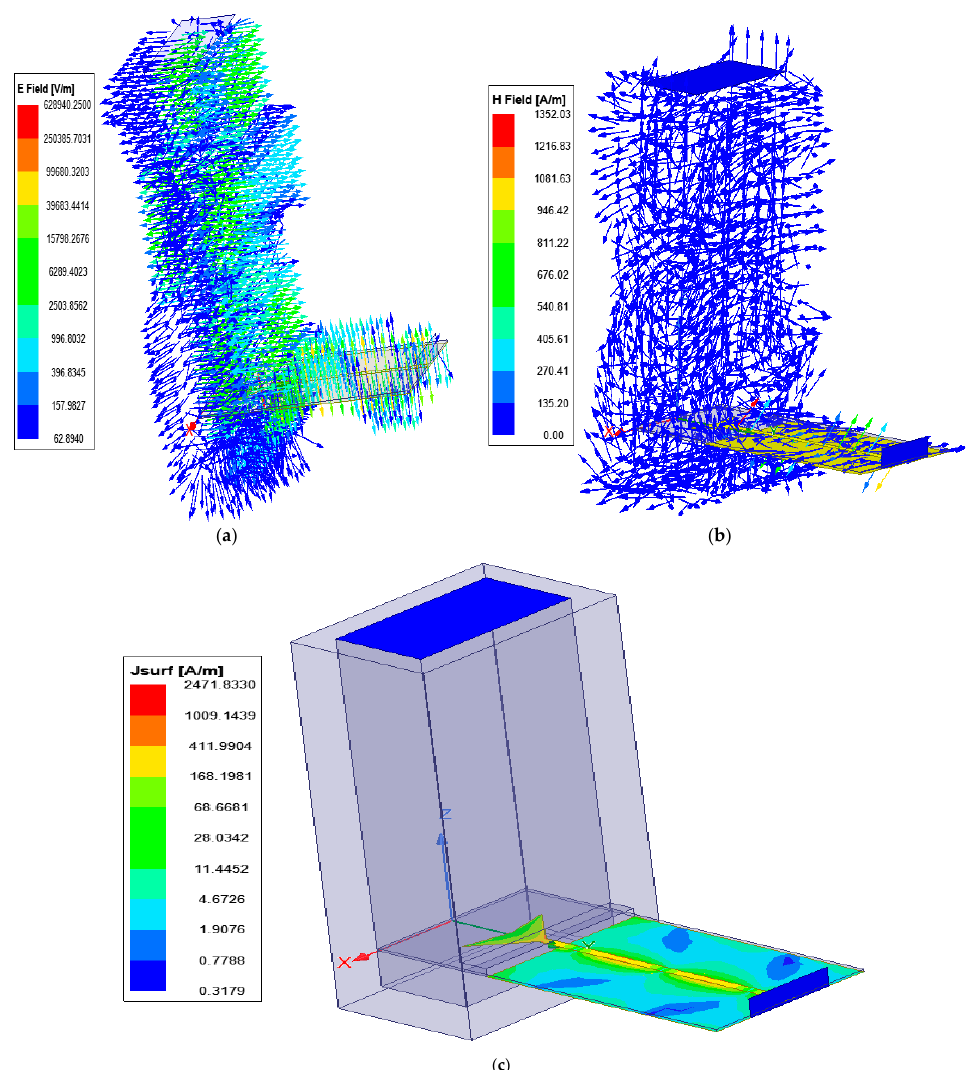
Figure 11. ( a ) Electric field (E) distribution in transition, ( b ) magnetic field (H) distribution in transition, and ( c ) conduction current density (J) distribution in transition at 30 GHz.